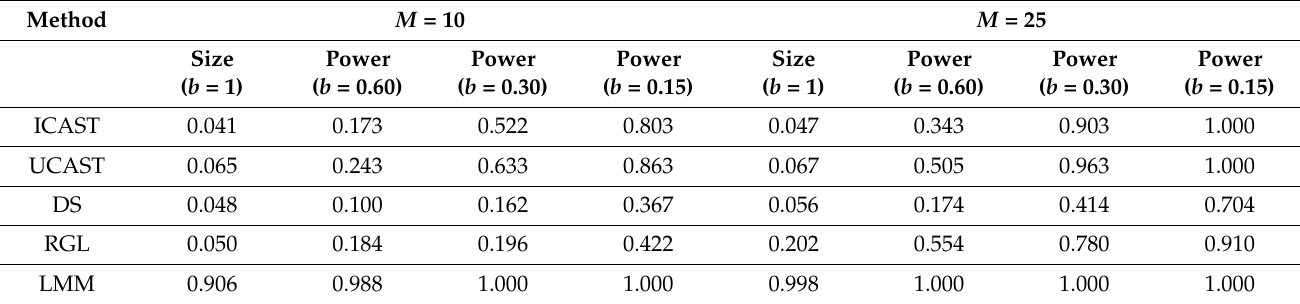
Table 2. Empirical size (type-I error rate) and power performances of different methods for clustered data with informative cluster sizes under Simulation Scenario 2. Here M is the number of clusters and b represents the true effect-size where b = 1 denotes H 0 is true and any other value of b denotes H 0 is false. The nominal/target size (type-I error rate) is 0.05 and empirical size of any valid test should not exceed 0.05 irrespective of its